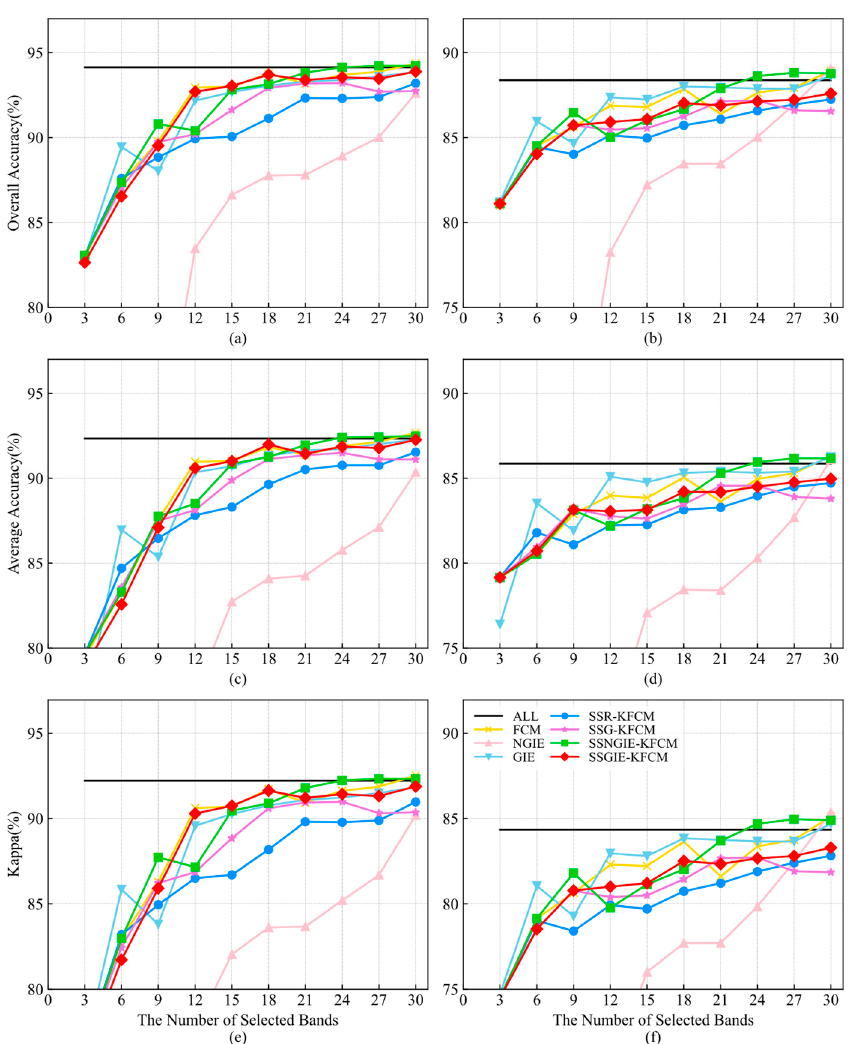
Figure 11. Ablation results on the Pavia University dataset. ( a , c , e ) are SVM classifiers; ( b , d , f ) are KNN classifiers.